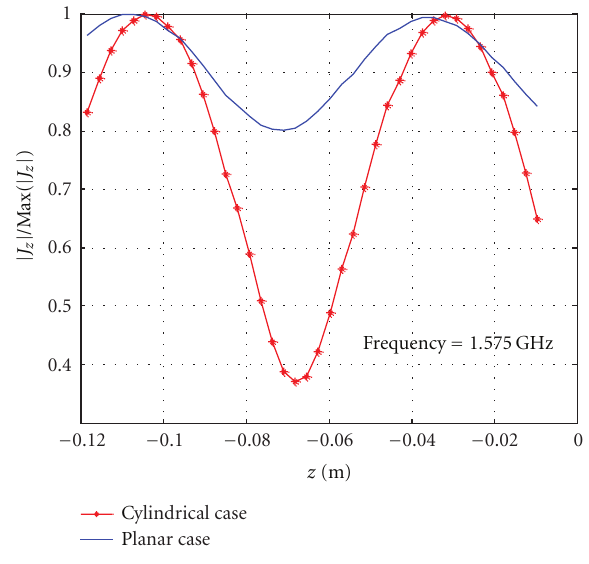
Figure 9: Comparison of the current distribution on